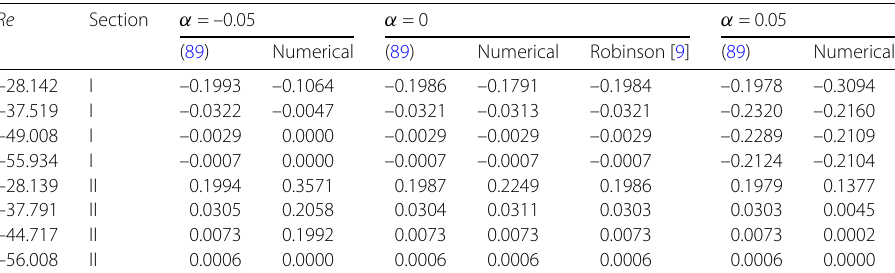
Table 1 Numerical values of g (cid:3)(cid:3)(cid:3) ( η ) at η = 0, for various Re in different sections, compared with the analytical formula (89)